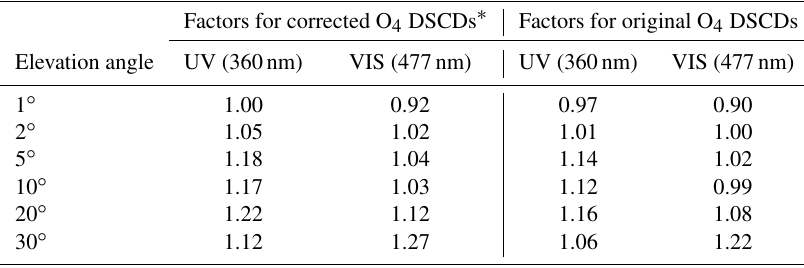
Table 6. The finally determined O 4 DSCD scaling